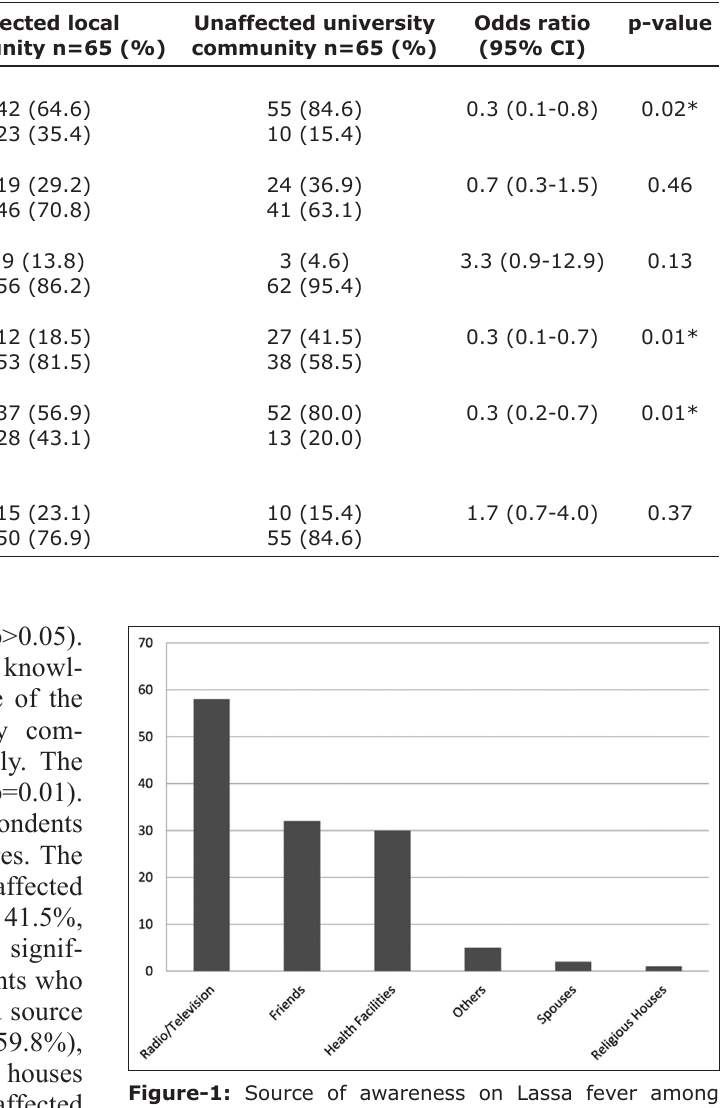
Figure-1: Source of awareness on Lassa fever among respondents in both affected local and unaffected university communities, Ibadan, Nigeria